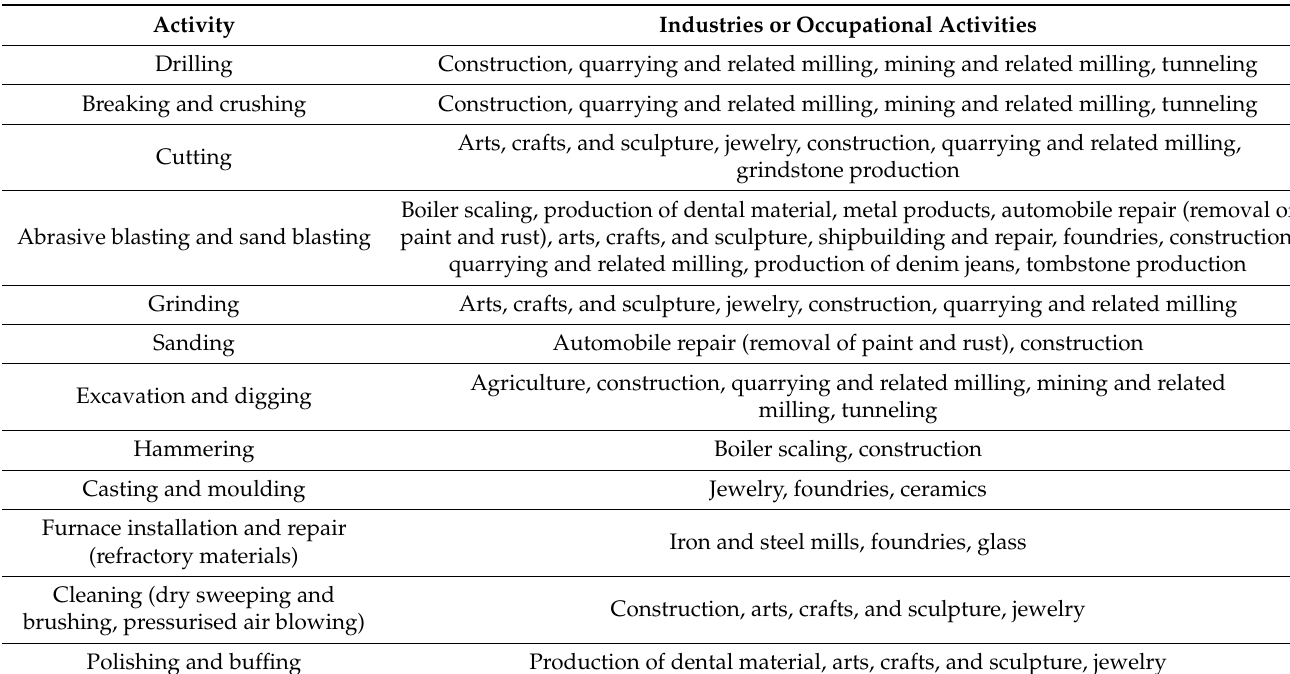
Table 1. Common operations or tasks that involve exposure to free crystalline silica [7,15,16]. Industries or Occupational